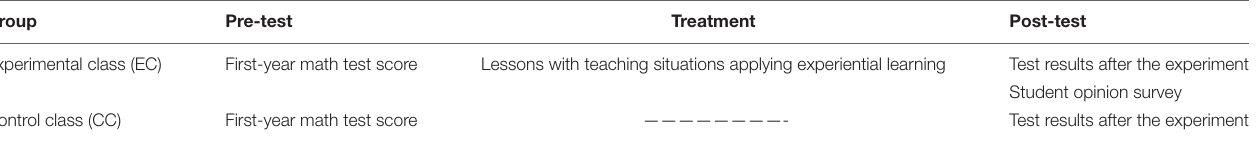
TABLE 3 | Quasi-experimental study design.